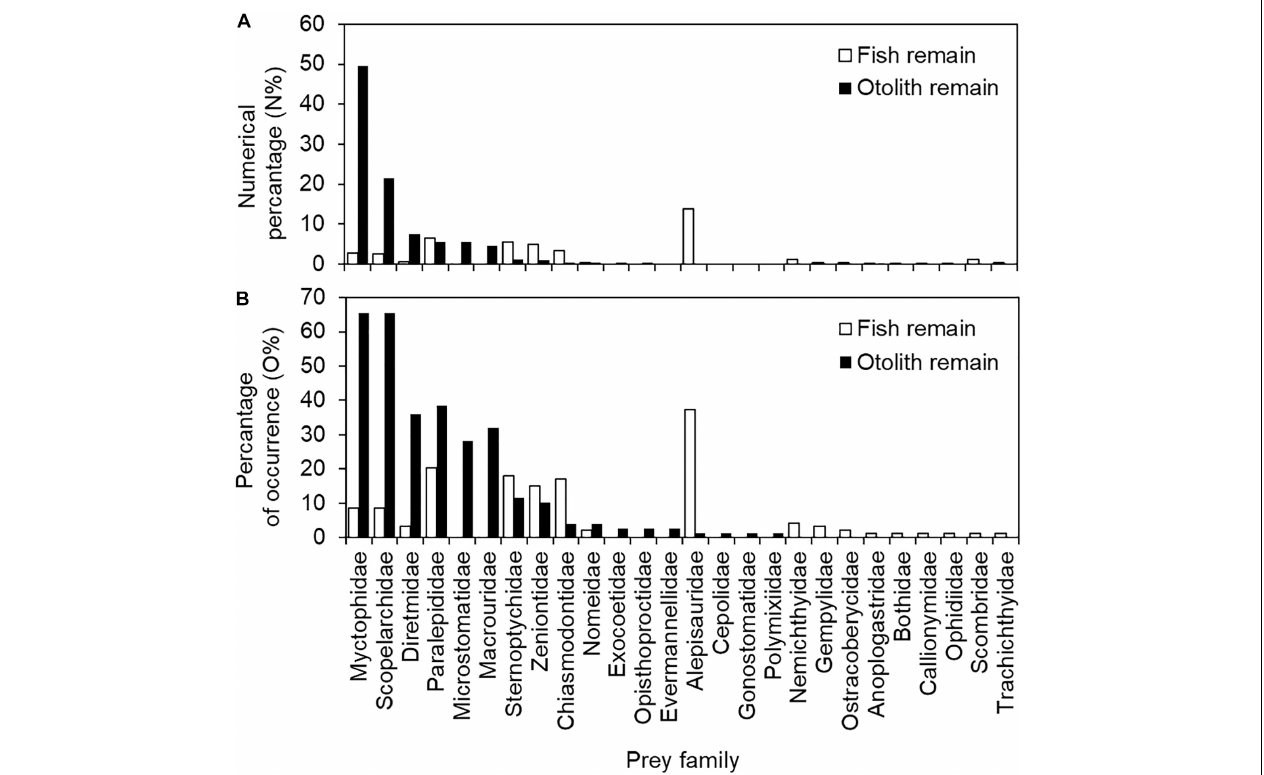
FIGURE 4 | Numerical percentage (%N) and percentage of occurrence (%O) in (A) 94 fish remain-containing and (B) 78 otolith remain-containing stomachs of bigeye tuna ( Thunnus obesus ).